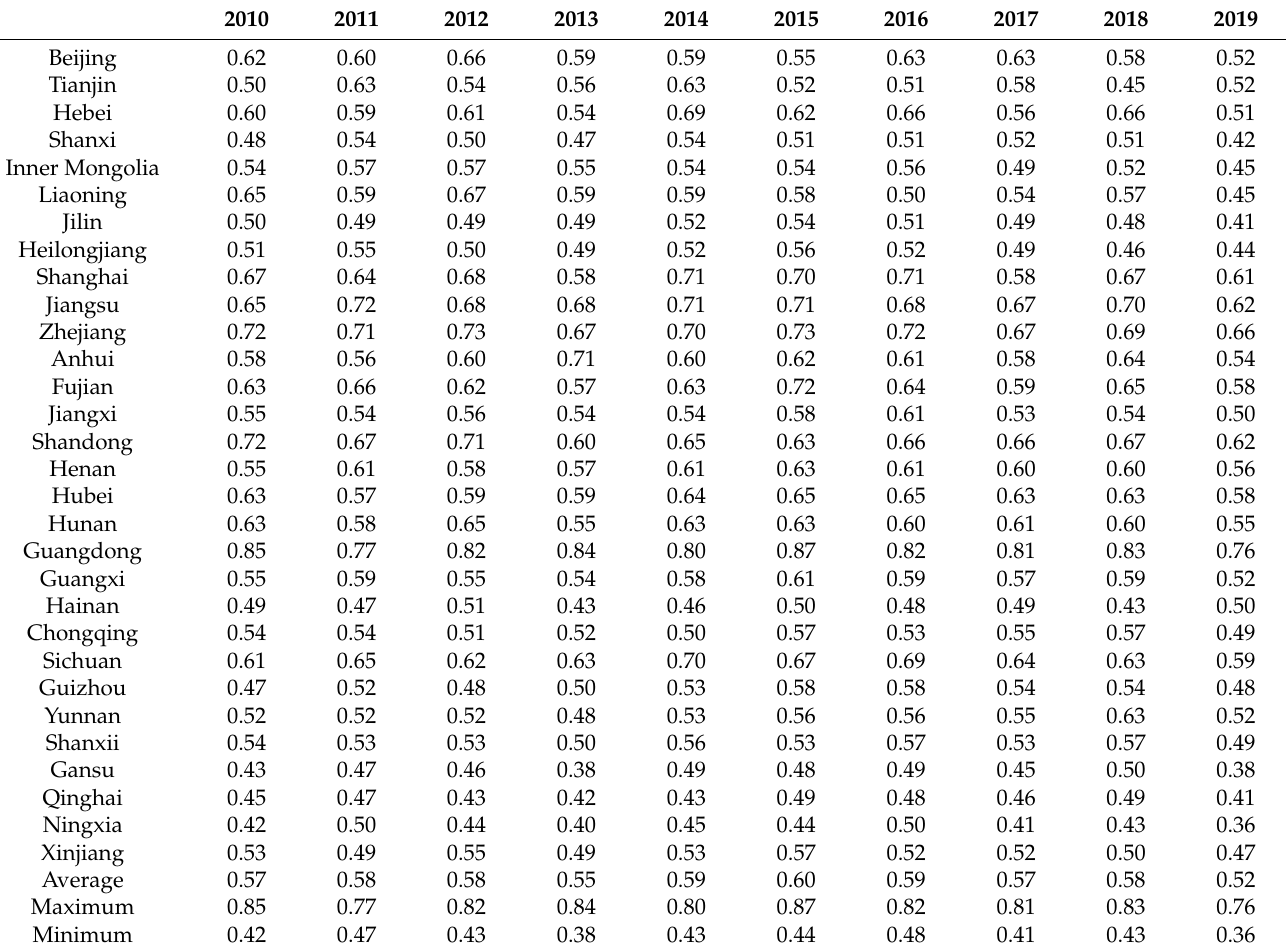
Table 5. Coupling coordination degree of regional logistics and ecological environment from 2010 to